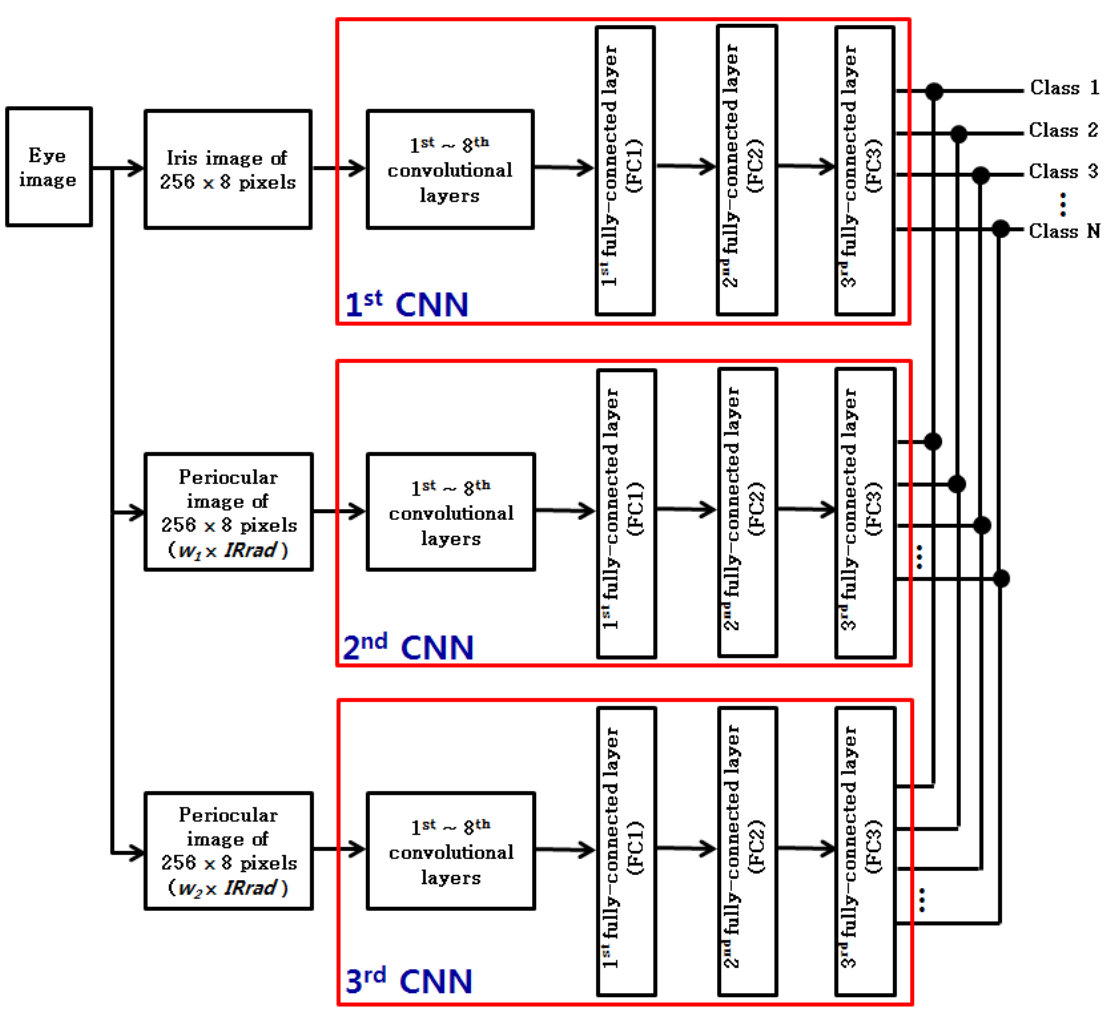
Figure 7. Proposed structure of three CNNs for training and testing.